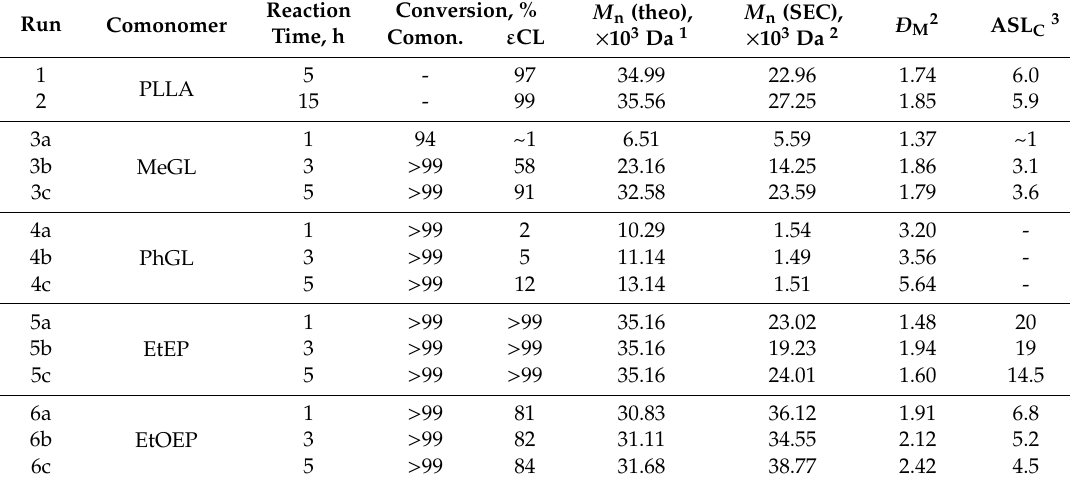
Table 3. Copolymerization results for ε CL using 3 / BnOH catalysis (0.5 M comonomer and 2.5 M ε CL solutions in toluene, [Comon] / [ ε CL] / [3] / [BnOH] 50:250:1:1, 100 ◦